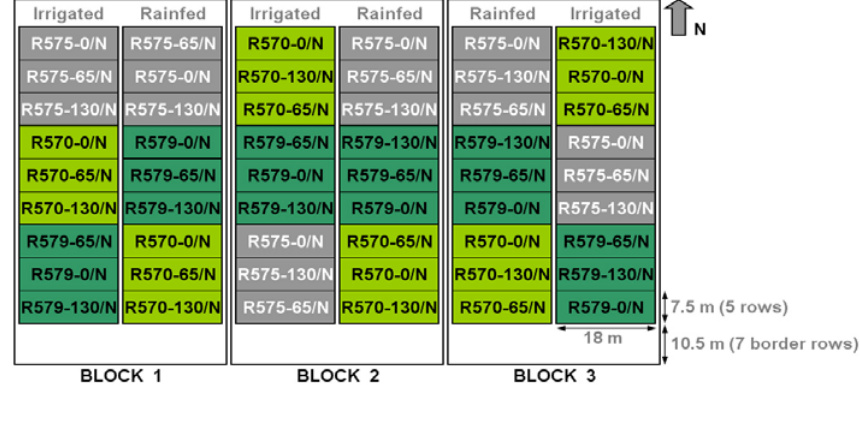
Figure 3. Layout of the La Mare 2007 experimental trials: irrigated/rainfed, three sugarcane cultivars (R570, R575, R579), and three nutrient inputs (0N, 65N, 130N), three replications